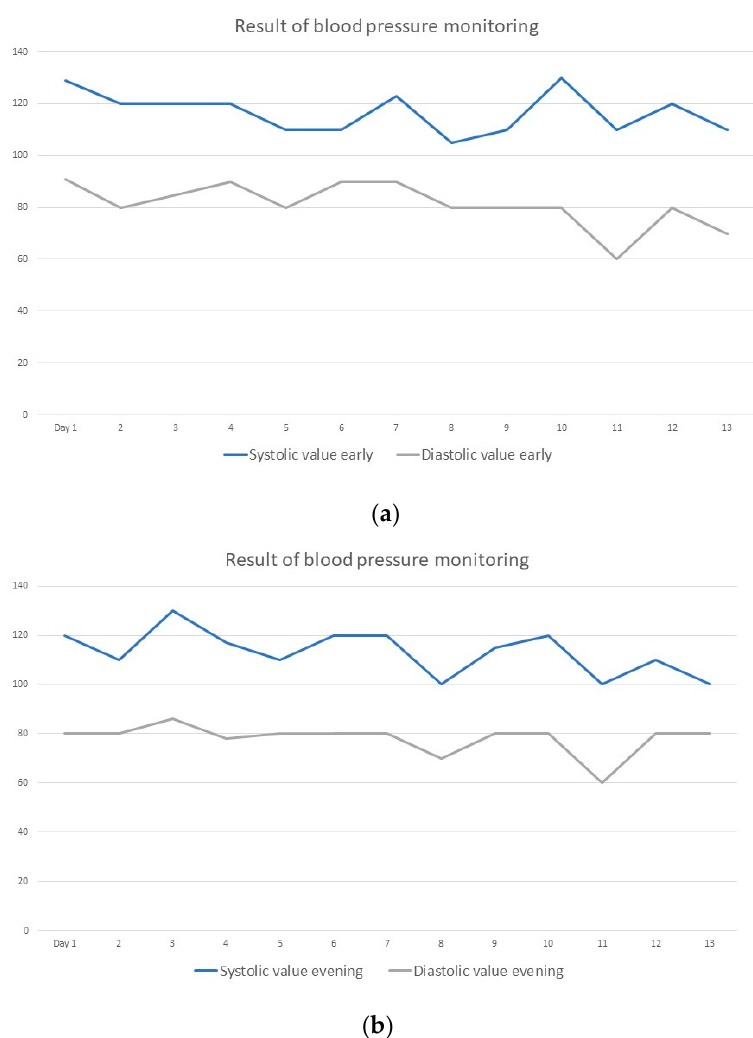
Figure 3. ( a ) Blood pressure monitoring in the morning; ( b ) blood pressure monitoring in the evening. The average treatment time was 80.2 min.